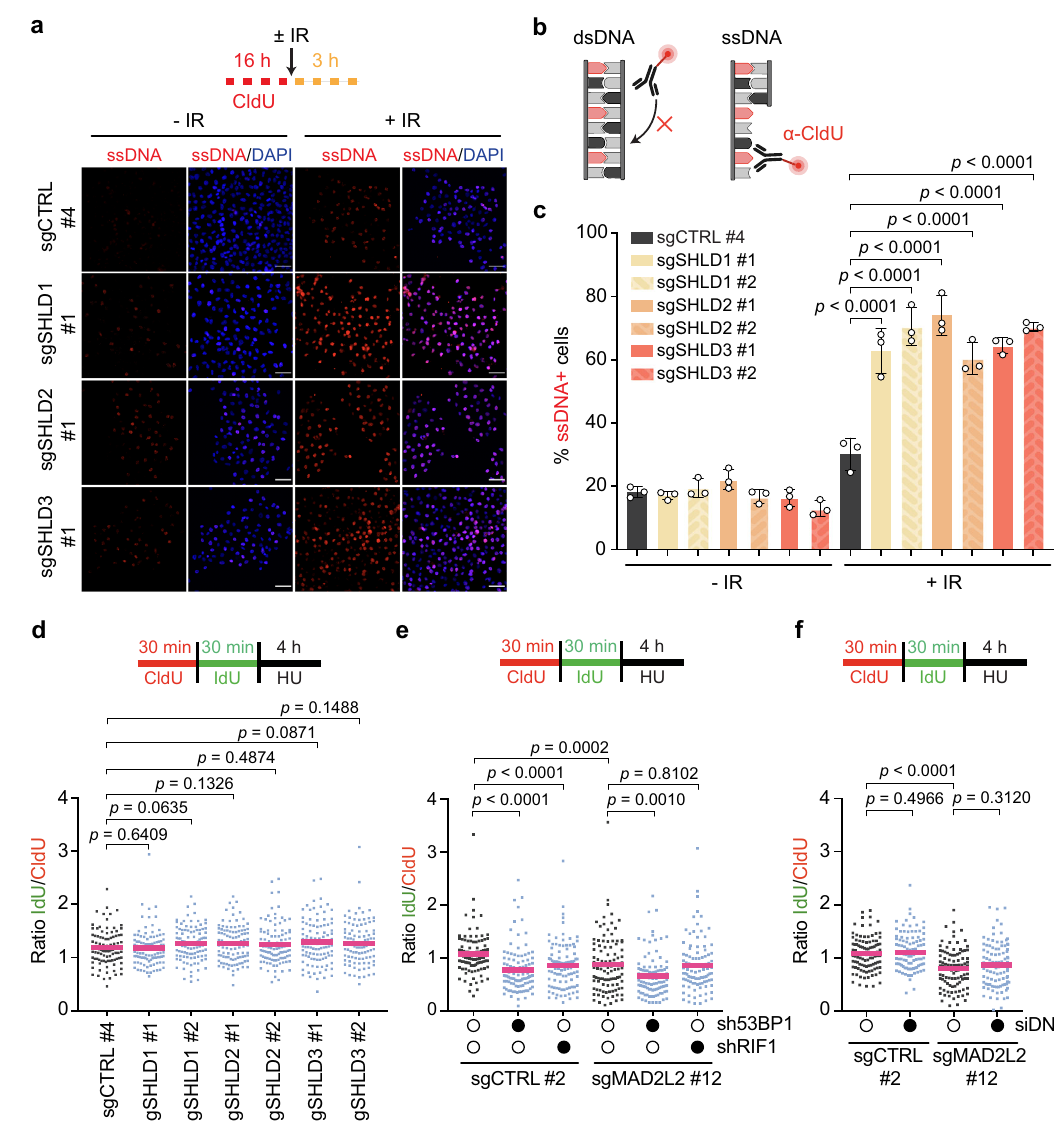
fi ber experiment from three independent biological replicates is shown. labeled as indicated above. A representative fi ber experiment from two indepen- dent biological replicates is shown. Statistical analysis for the fi ber assays in ( d – f ) wasperformedaccordingtotwo-tailedMann-Whitneytest.Pinkbarsrepresentthe mean. Additional replicates and combined fi ber plots are provided in the Supple- mentary